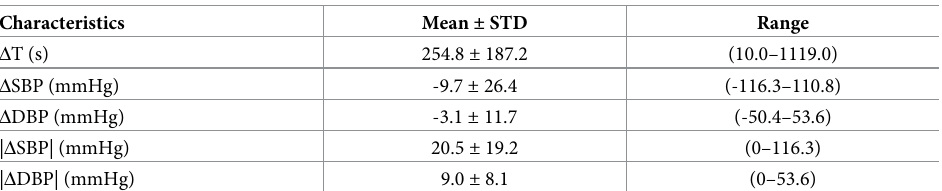
Table 2. Characteristics of